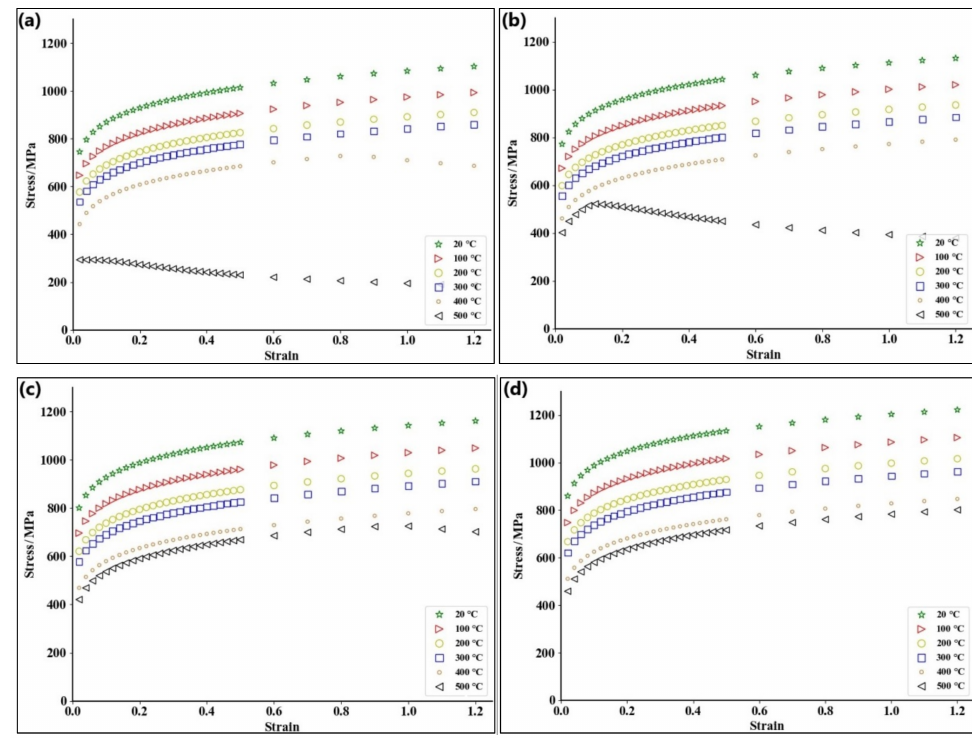
Figure 4. The yield strength of AlFeSi phase under quasi-static conditions.